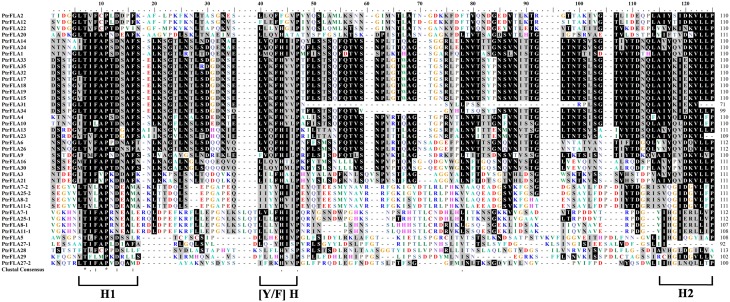
Multiple sequence alignment of fasciclin domains in Populus trichocarpa. The alignment was generated using Clustal W program and manual modification. If a protein sequence contains two fasciclin domains, numbers 1 and 2 were used to distinguish them based on the distance to N-terminus. The conserved regions (H1, H2, and [Y/F]H) of fasciclin domains are indicated in the bottom. Identical and conserved residues are shaded in black and dark gray, respectively.